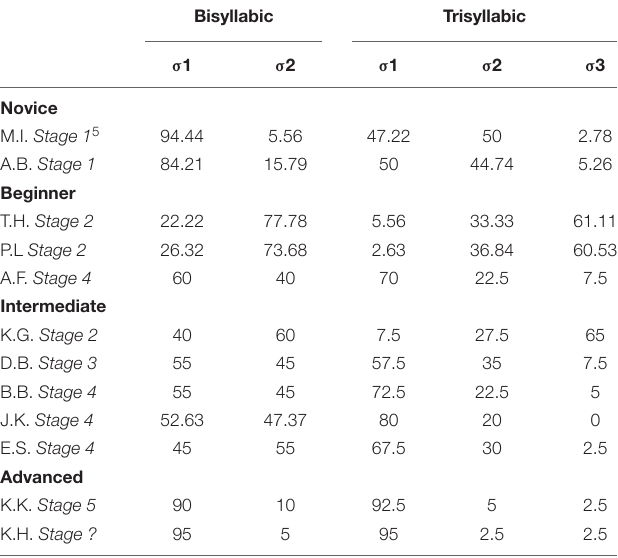
TABLE 5 | Individual results on stimuli with all light syllables: percentage stressed. Bisyllabic